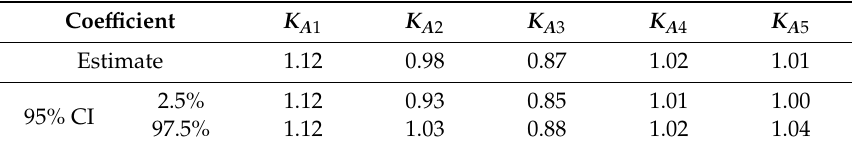
Table 3. Coe ffi cients of the Regression Models.